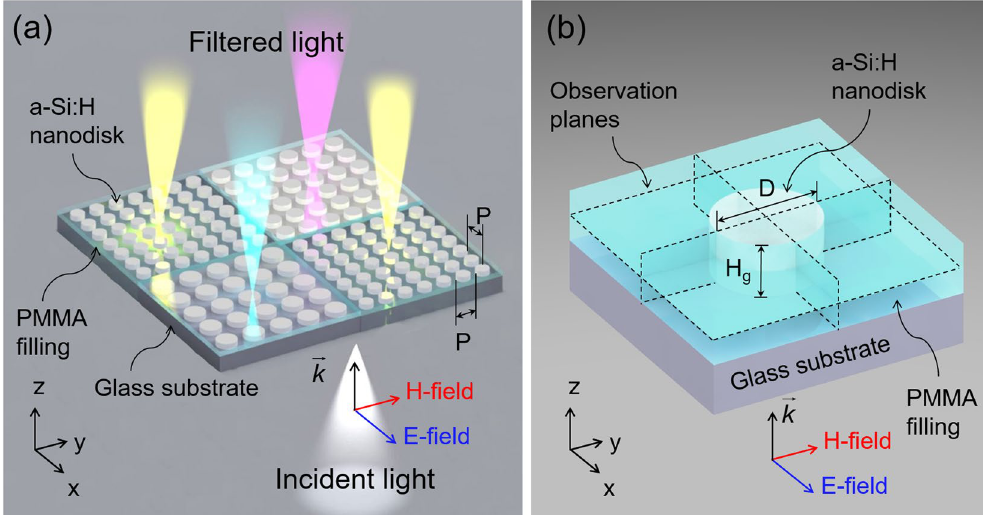
Figure 1. Configuration of the proposed structural color filters resorting to an a-Si:H metasurface. ( a ) Each filter consists of a 2D lattice of a-Si:H nanodisks on a glass substrate. The nanodisk is embedded in a polymeric material of PMMA, which serves as an index-matching layer. The incident white light is filtered into distinct visible colors depending on the period P and the diameter D. ( b ) Schematic of a unit a-Si:H nanodisk, with the observation planes defined by the dotted